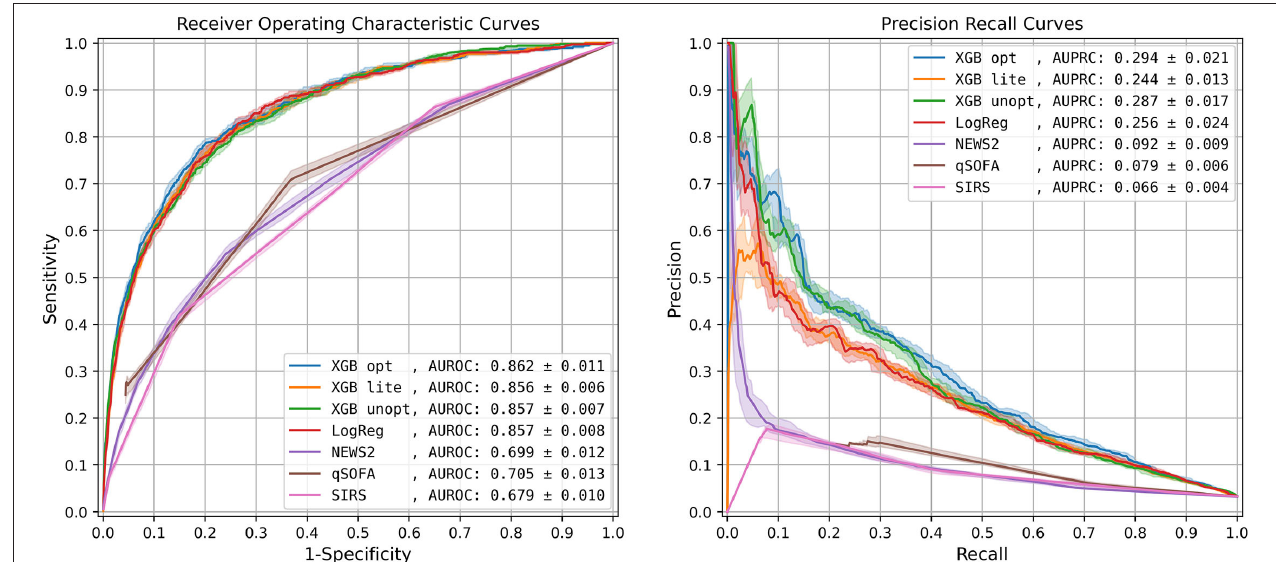
FIGURE 1 | Model performance: Receiver Operating Characteristic curve and Precision-Recall curve. The solid lines represent the 50th percentile curves based on 20 bootstraps (full resampling with replacement) iterations of the test dataset, and the shaded regions represent the area between the 25th and 75th percentiles. AUROC, area under receiver operating characteristic curve; AUPRC, area under precision recall curve; XGB opt, optimized XGBoost model; XGB lite, simple XGBoost model; XGB unopt, unoptimized, out-of-the-box XGBoost model; LogReg, logistic regression; NEWS2, National Early Warning Score 2; qSOFA, quick Sequential Organ Failure Assessment; SIRS, Systemic Inflammatory Response Syndrome.